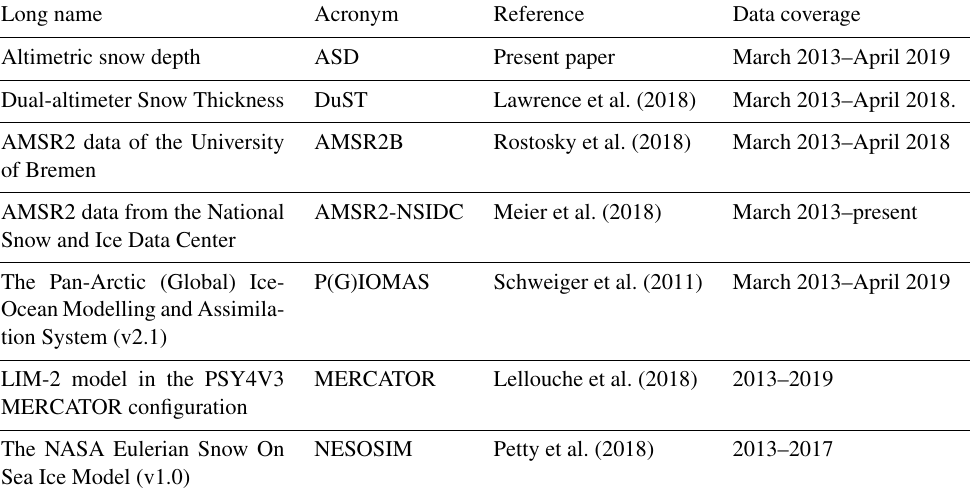
Table A4. Time period of snow depth products used in this article. Note that the current data availability may have changed since this article was